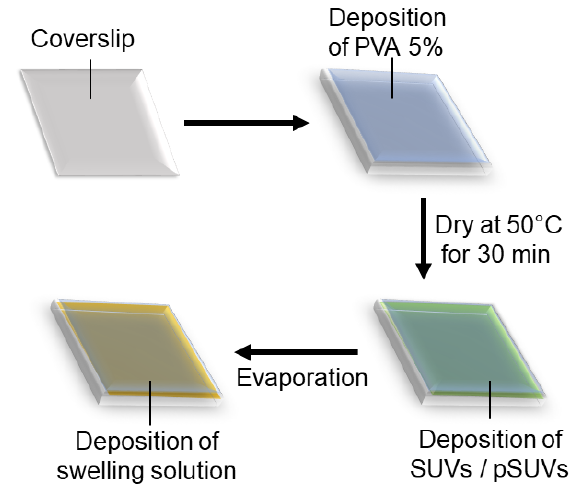
Figure 1. Schematic representation of the protocol for PVA-assisted swelling of GUVs incorporating integrins. A glass coverslip is coated with an aqueous solution of PVA which is dried, then coated with a solution of previously prepared SUVs which is again dried. In the last step, the swelling buffer is deposited. The PVA as well as the dried lipid–protein mixture are hydrated, and GUVs are